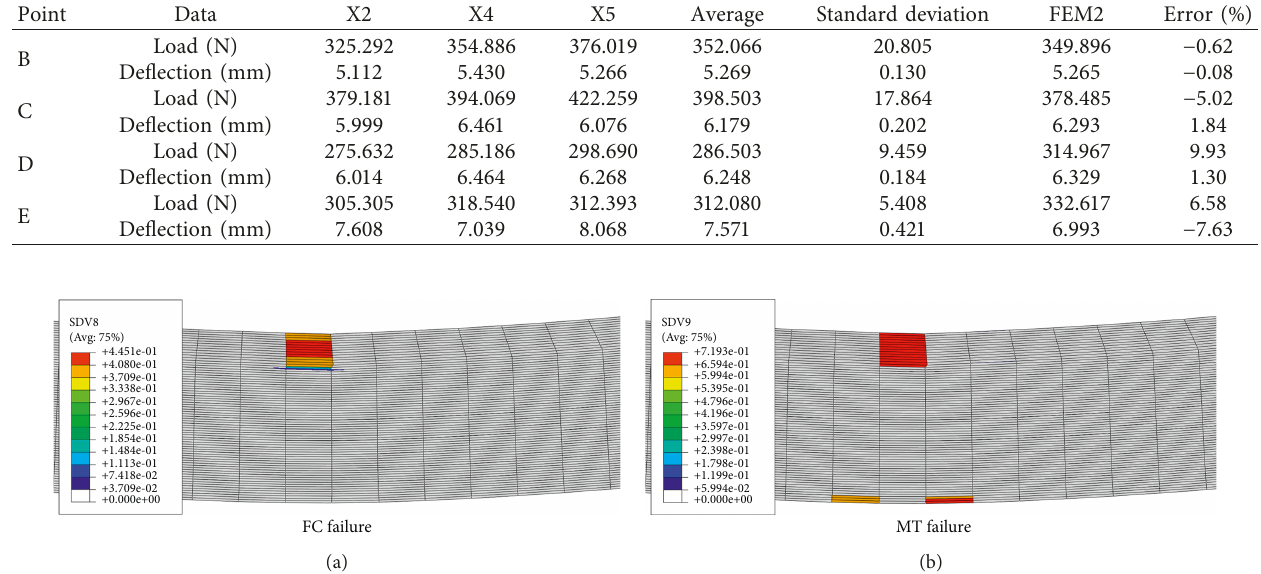
Table 4: Comparison of characteristic points between simulation and experiments.